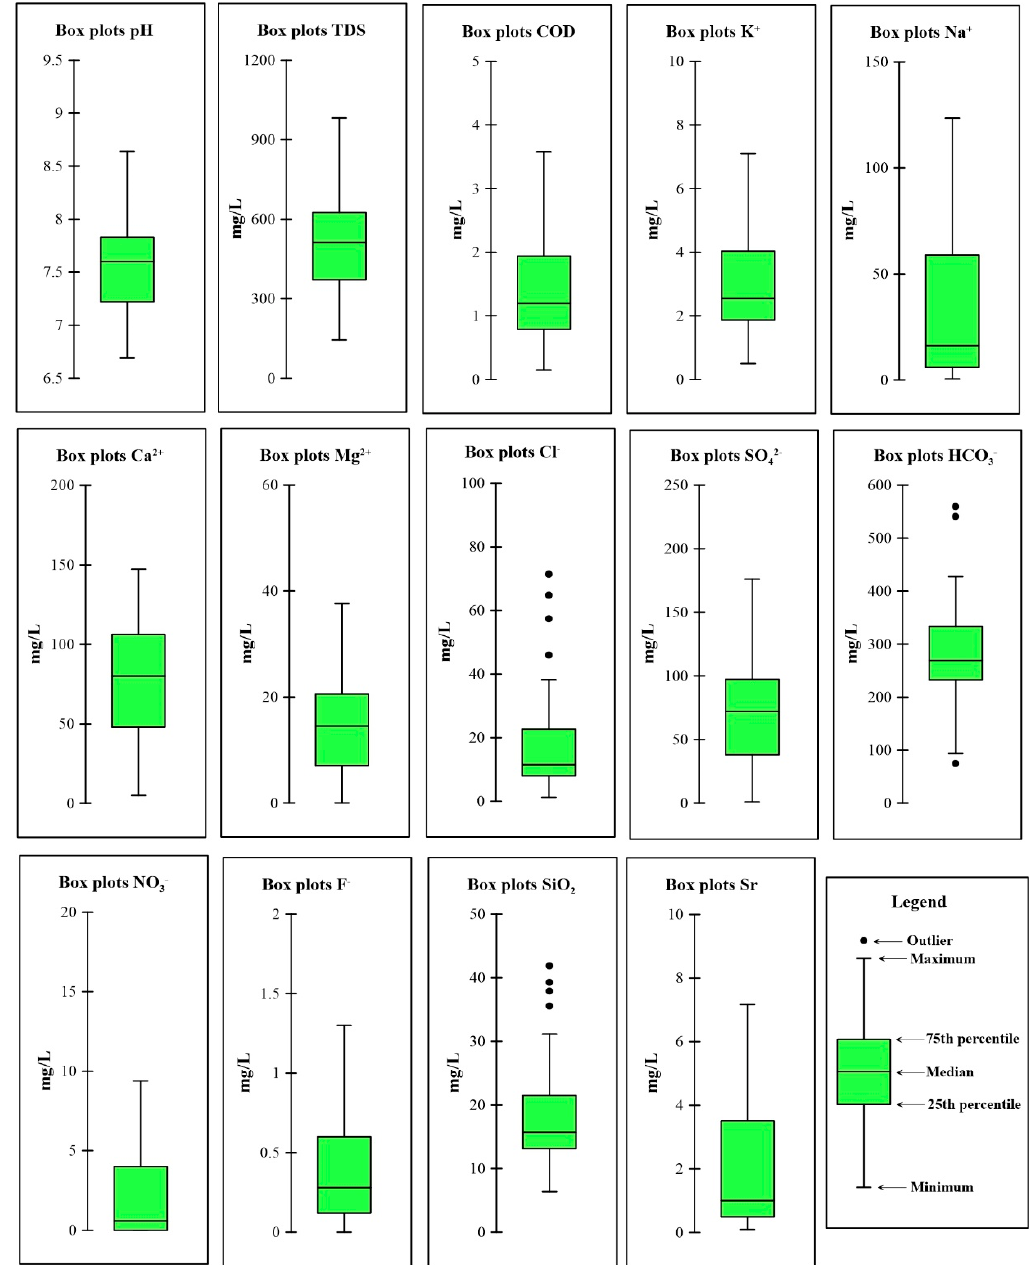
Figure 3. Box and Whisker plot of chemical parameters of groundwater samples.